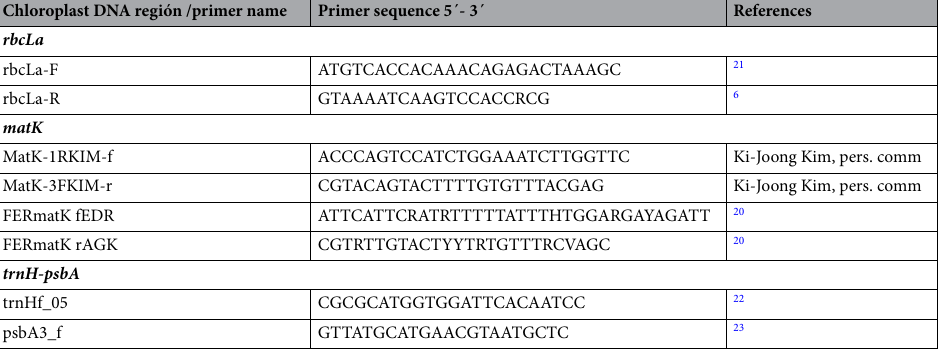
Table 1. Primer sequences used for DNA amplification of chloroplast regions rbcLa , matK, and